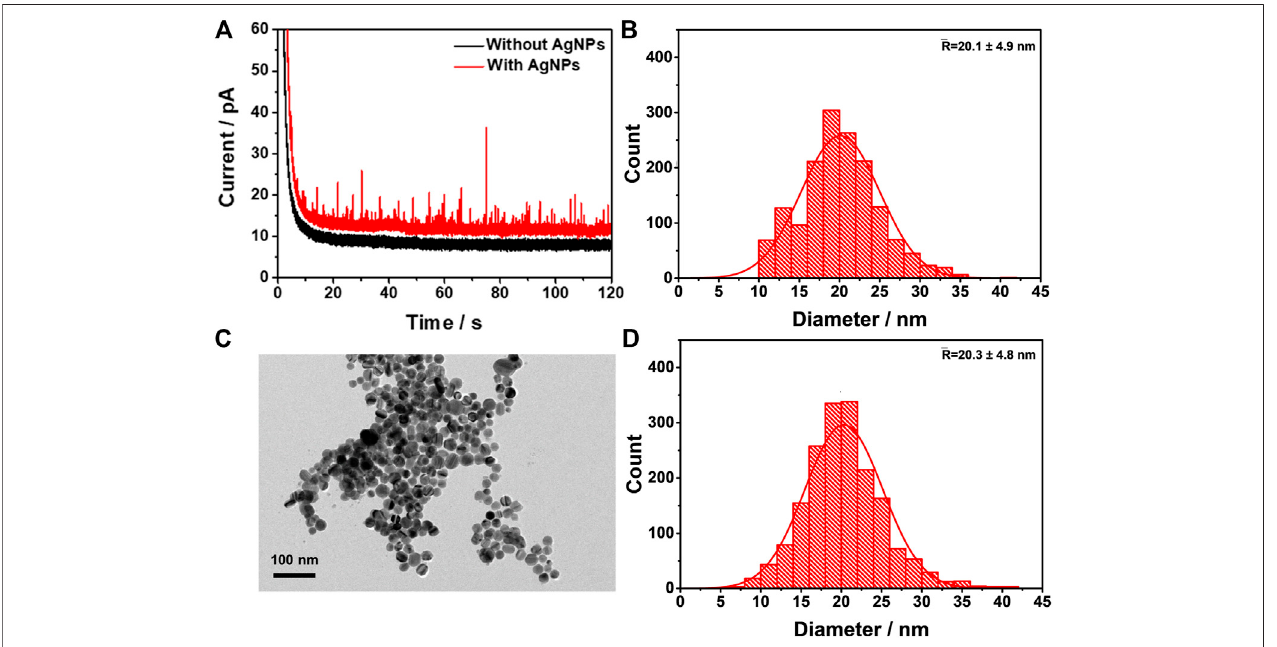
FIGURE4| Veri fi cationofthespikedetectionalgorithm (A) Arepresentativechronoamperometricpro fi leofAgNPsNIE.Theblackandredlineindicatetheabsence and the presence of the AgNPs in solution, respectively (B) Histogram of the size distribution of AgNPs from the integrated charge processed by the algorithm (C) A representative TEM image of the AgNPs (D) Histogram of the size distribution of AgNPs derived from TEM determined by a Nano Measurer software.